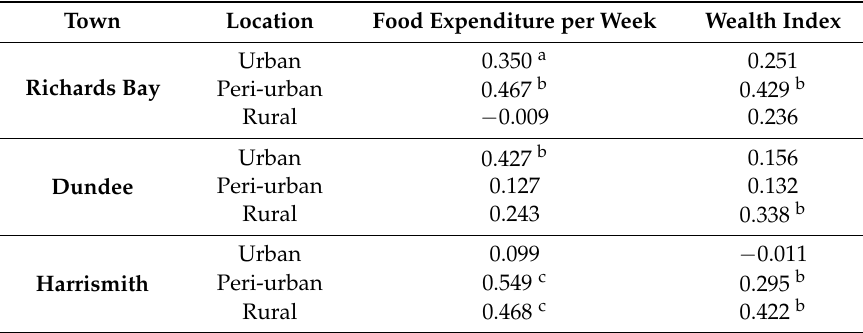
Table 4. Spearman correlations between MDD-W and both wealth index and food expenditure within